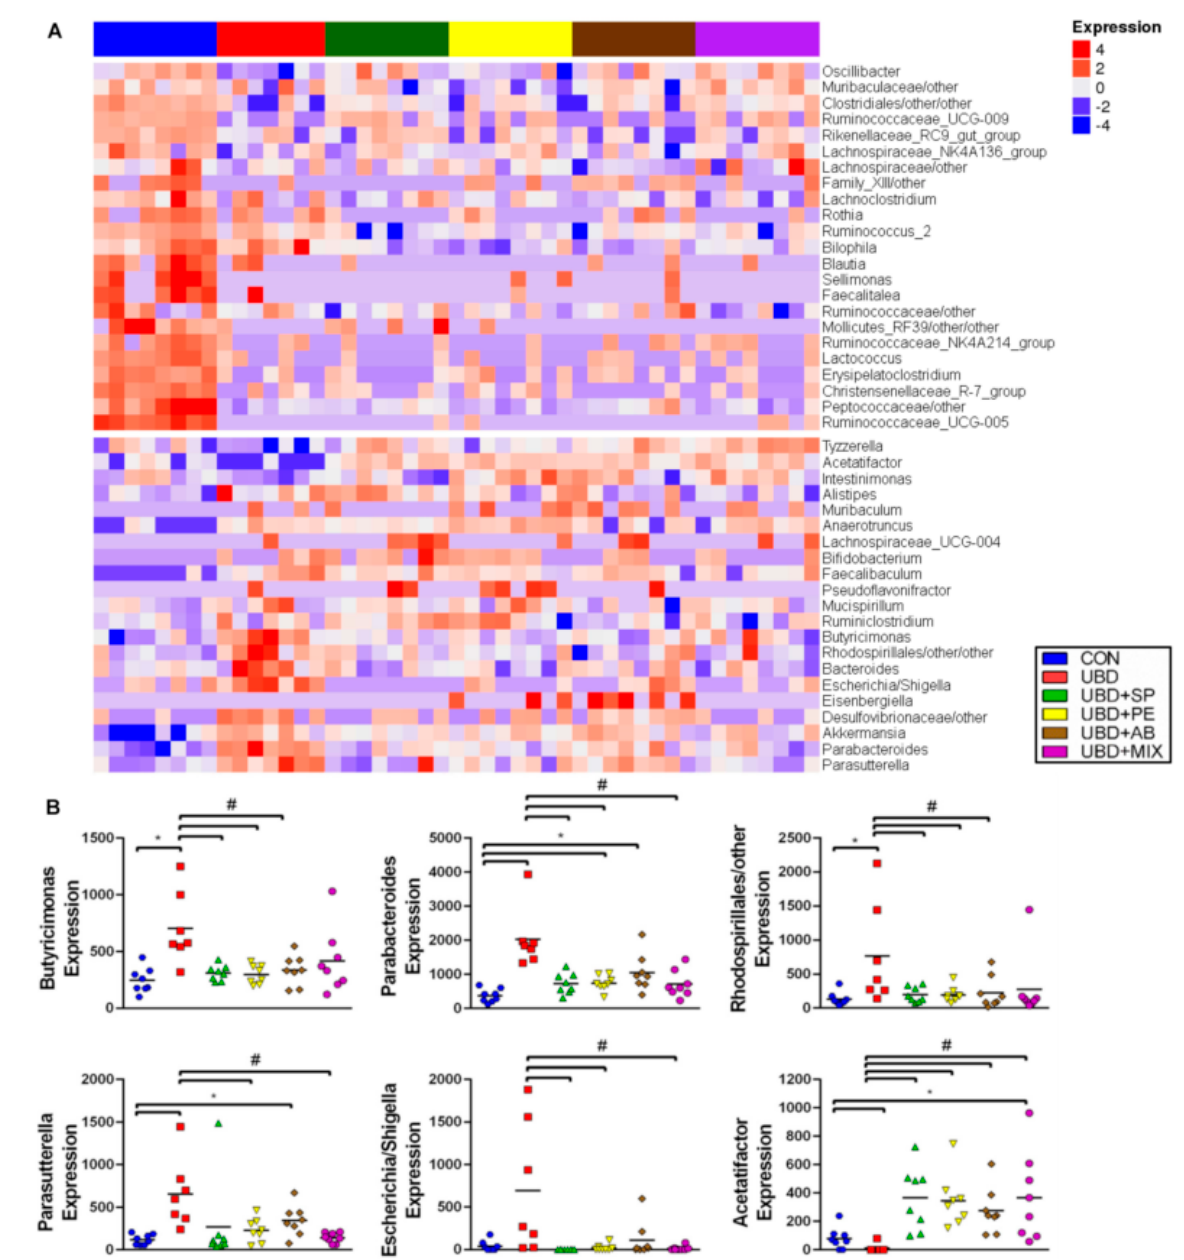
Figure 8. Change in the bacterial profile. ( A ) Results were analyzed using Deseq2 and assessed using heatmap. ( B ) Differen- tial abundance analysis was carried out using Deseq2 on the counts products. p value was adjusted for multiple testing by Benjamin-Hochberg procedure (Padj < 0.05). (*) Significant difference compared with the CON group. (#) Significant difference compared with the UBD group.